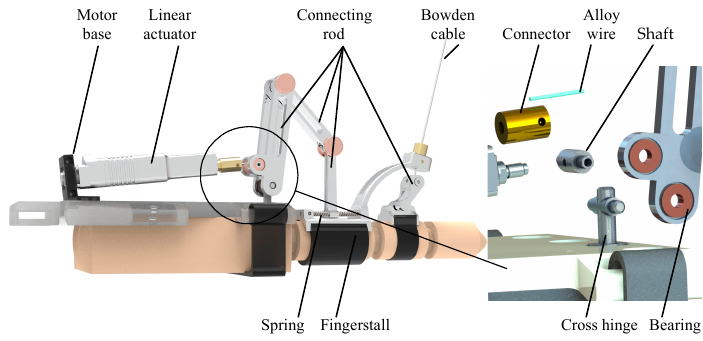
Figure 3. The MCP joint and PIP joint mechanisms of the index finger.